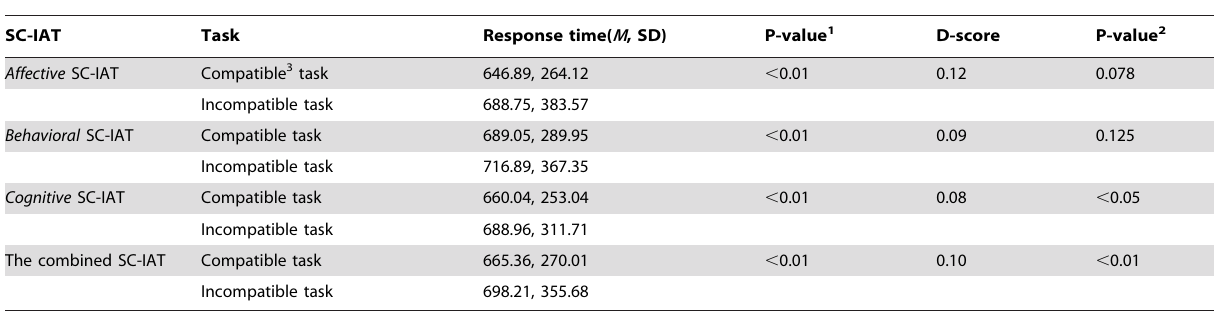
Table 2. Response time and D scores of three SC-IATs.